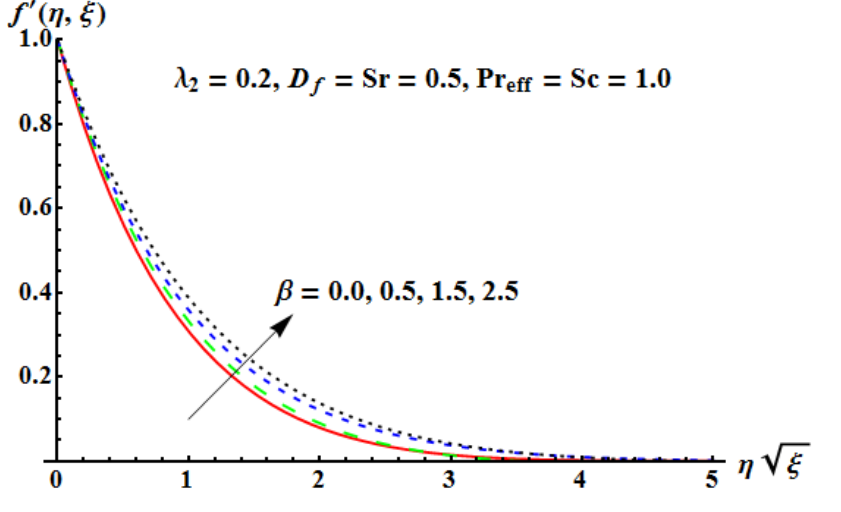
Figure 8. Influence of β on f (cid:48) ( η , ξ ) .